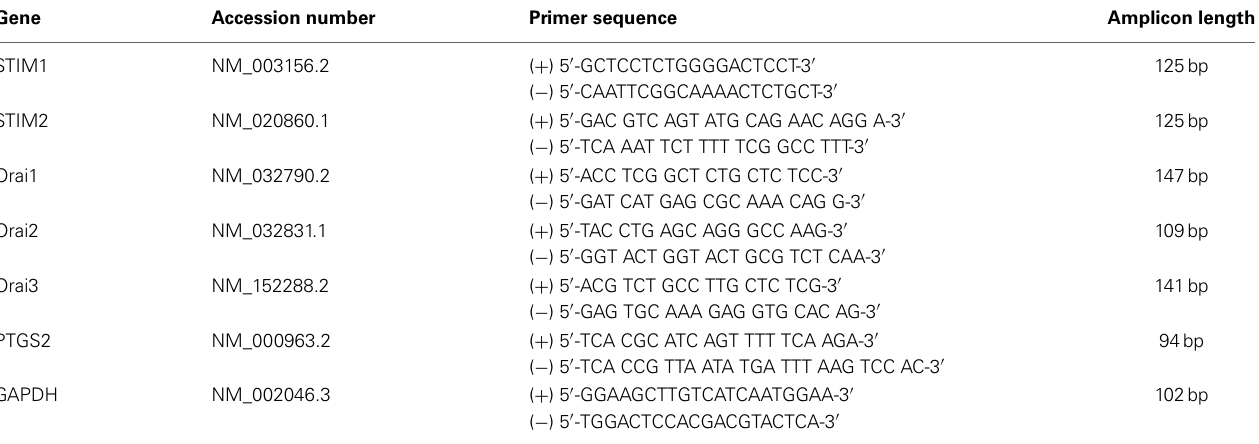
Table 1 | Real-time PCR primer sequences.